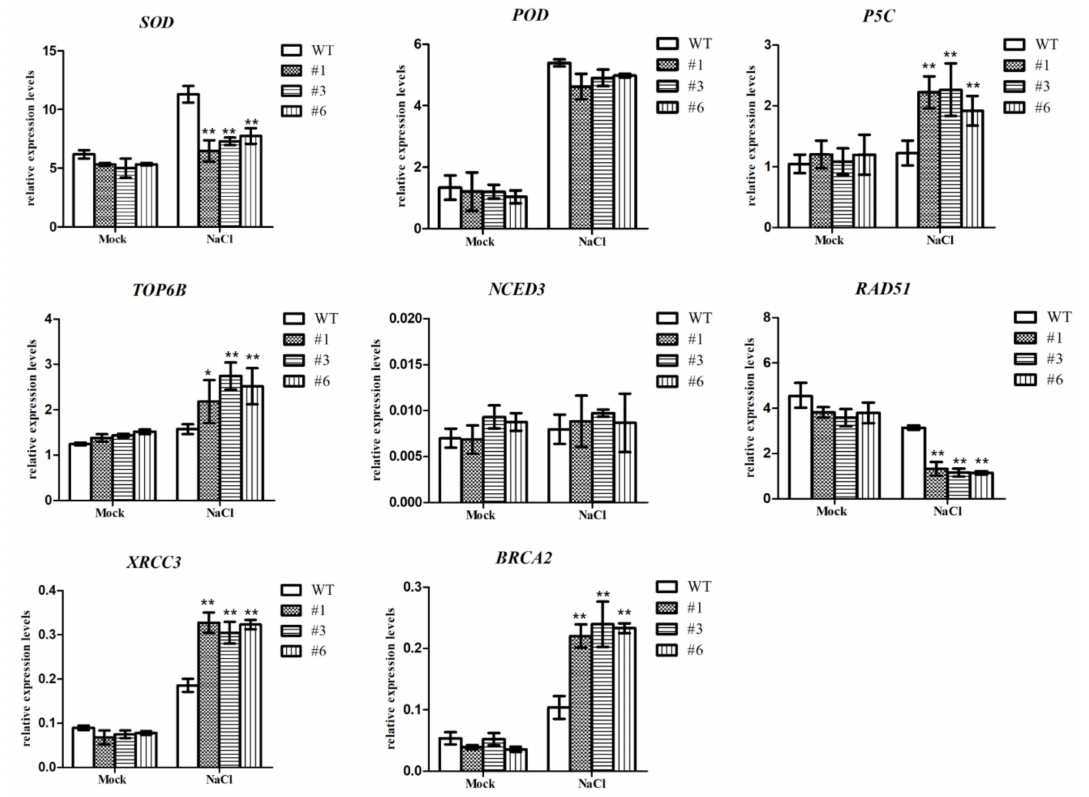
Figure 7. Expression levels of stress-related genes ( SOD , POD , P5C , TOP6B , NCED3, RAD51 , XRCC3 and BRCA2 ) in control plants and BrDMC1 -RNAi. The values were means ± SE of three independent experiments. (** p < 0.01 and * p <